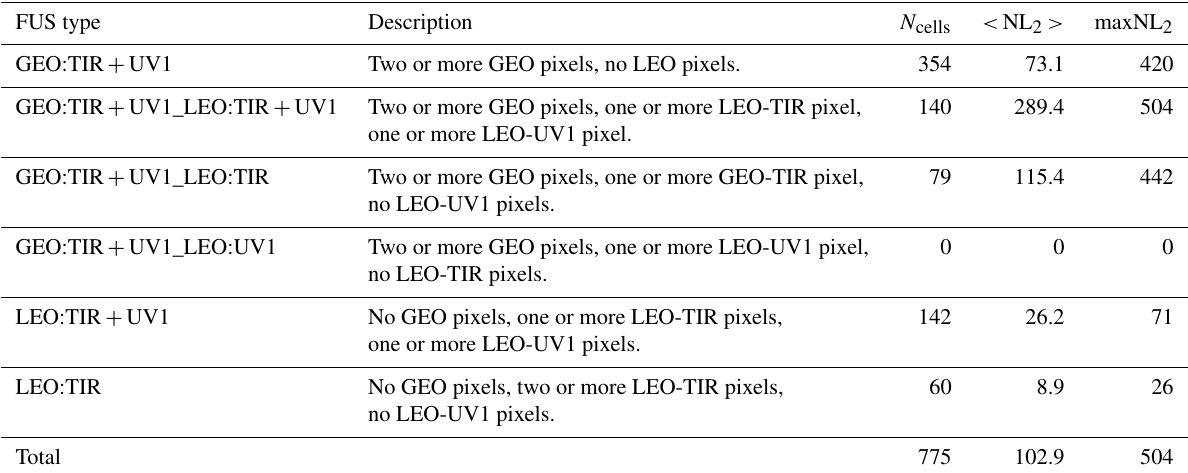
Figure 7. (a) SF AK vs. vertical level. (b) SF ERR vs. vertical level. In both panels, the different colours of the symbols represent the FUS type, and the different sizes of the symbols represent the number of measurements that have been fused. The maximum symbol size shown in the legend corresponds to N = 160. Table 4. Like in Table 2 but with a grid box size of 1 ◦ × 1 ◦ . N cells is the number of grid boxes characterized by the considered FUS type. < NL 2 > is the mean number of individual L2 fusing profiles per grid box and maxNL 2 is the maximum number of individual L2 fusing products per grid